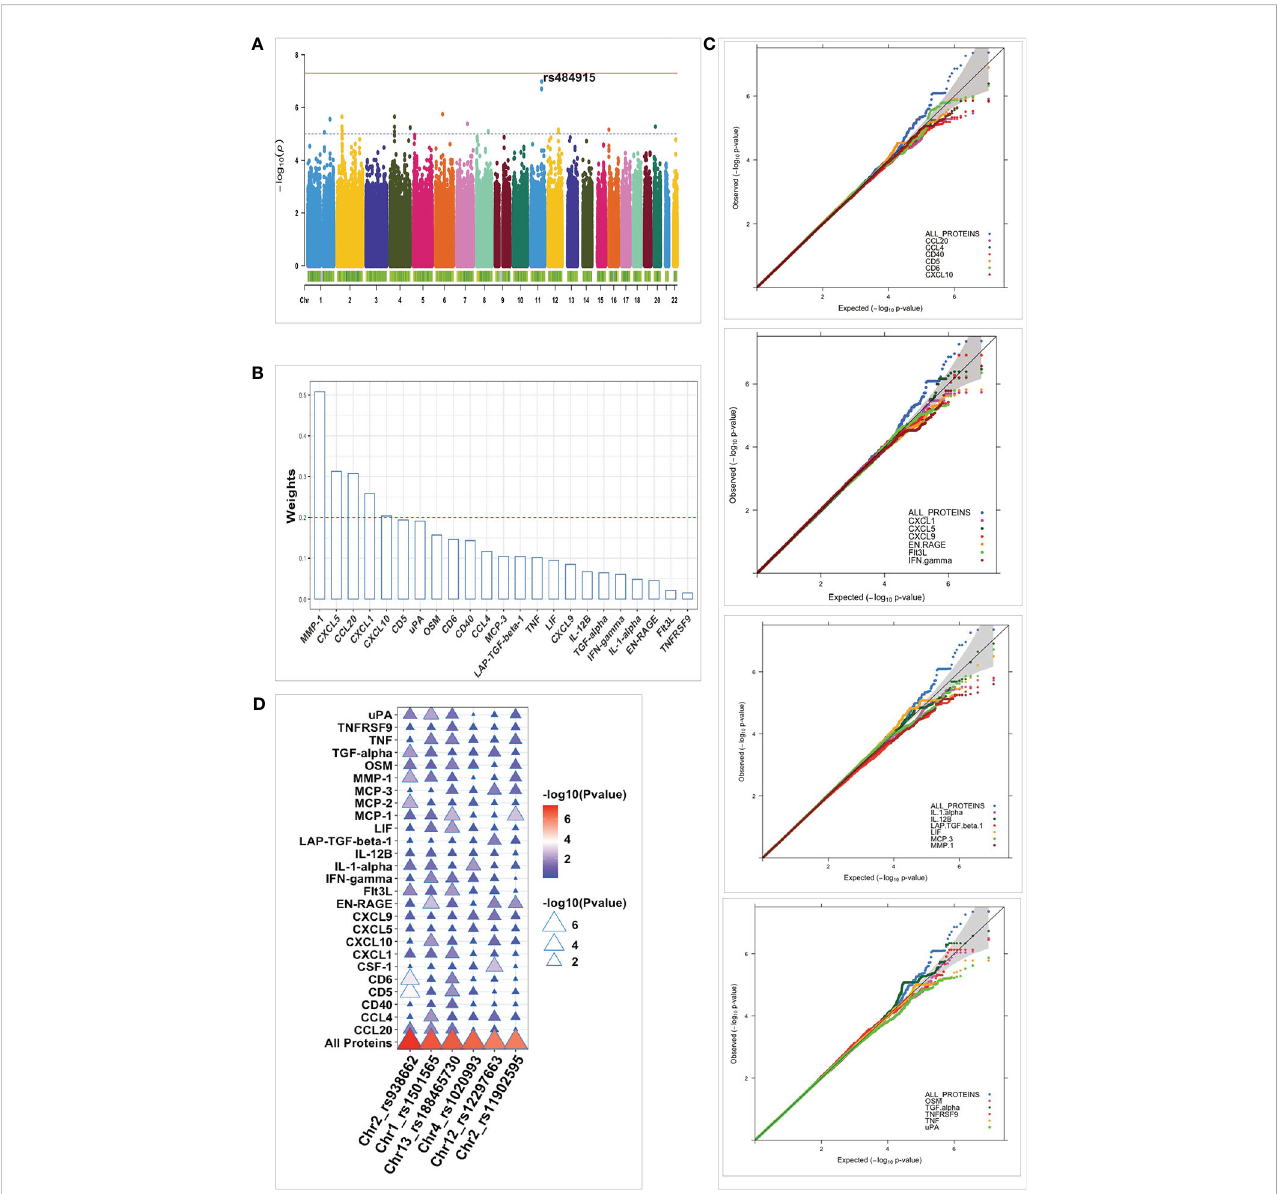
FIGURE 5 Summary of multivariate QTL mapping results and comparison with pQTLs identi fi ed using univariate approach. (A) Manhattan plot for meta-analyzed pQTL multivariate analysis results of protein network. Strength of association (-log10 meta-p values) is shown on the vertical axis and the horizontal axis depicts the chromosomal position of plotted SNPs. The blue horizontal dashed line and the red bold line represent suggestive (p-value = 1 x10 -5 ) and genome-wide (p-value < 5 x10 -8 ) signi fi cant thresholds, respectively. (B) Barplot of the weights (contribution to the protein network association) on the vertical axis plotted against all proteins forming the network (horizontal axis) using “ ggbarplot ” function in R. The red dashed line represents the threshold of signi fi cant contributions. (C) Quantile-quantile (Q-Q) plots for the pQTL mapping results in the 500GF cohort. The p-values distribution of the multivariate analysis (ALL PROTEINS) results are shown in blue and the remaining colors correspond to p-values of proteins analyzed separately. The gray shaded area represents 95% con fi dence interval of the null hypothesis. (D) Plot of association results of all individual proteins and protein network (All Proteins) plotted against the top six independent SNPs (horizontal axis) identi fi ed after multivariate analysis in the 500FG cohort. The color legend represents strength of association of SNPs with protein levels (Pvalue), ranging from blue (weaker associations) to red (stronger